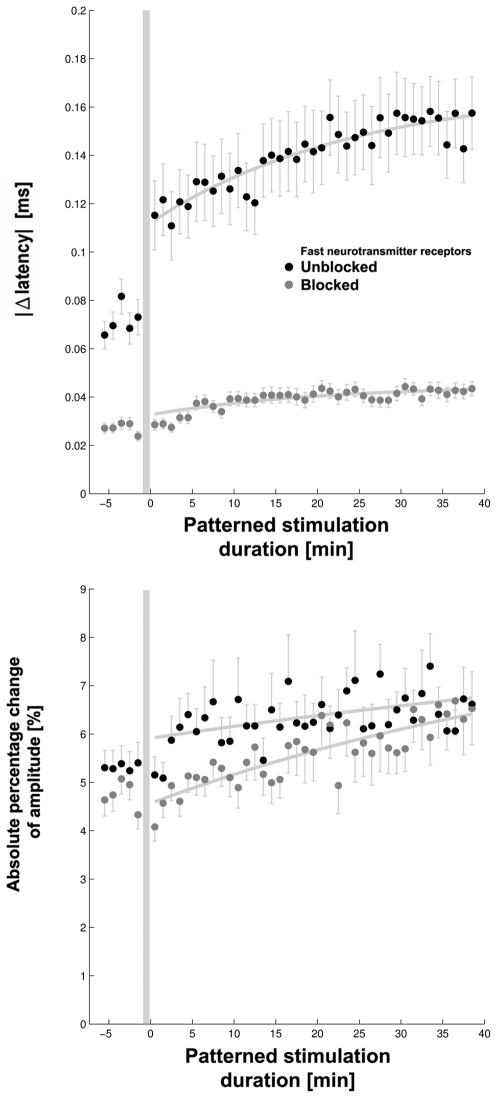
Changes in dAP propagation accumulated throughout the 40 minute duration of a patterned stimulation.DAP latencies (Top) and amplitudes (Bottom), from all experiments in Figure 3, were averaged over 1 minute time-bins and compared to those during the 1 minute time-bin just prior to shifting the location of the context electrode (shaded area). The absolute values of the changes in propagation were then averaged (dots; mean±s.e.m.). Exponential curves (thick lines) fit to the data indicate the rates of adaptation. Blocking sAPs minimized the effect of shifting the patterned stimulation that occurred at time = 0 min).